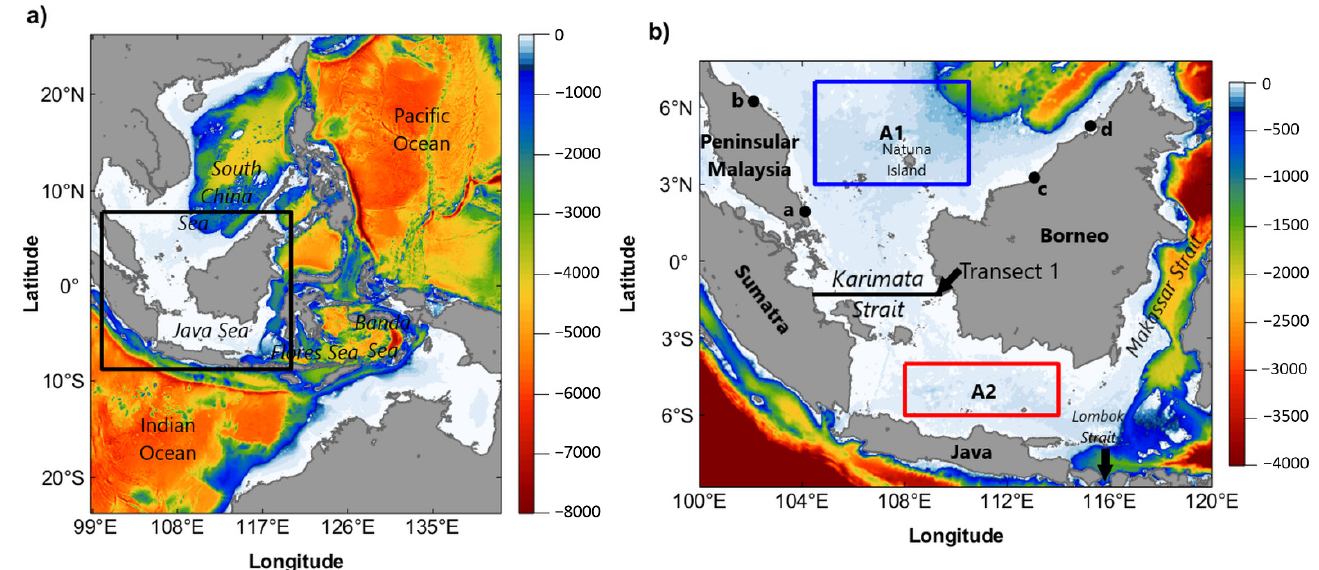
Figure 1. Model domain and bathymetry (unit: m). Black box in ( a ) represent the region of interest as shown in ( b ). Blue and red boxes in ( b ) represent the domains of the SSCS (A1) and the JS (A2). Black line in ( b ) is the transect (Transect 1) used to estimate various Karimata Strait transports (KSTs). Black dots in ( b ) mark the location of four tide gauge stations: (a) Tanjung Selidi, (b) Getting, (c) Bintulu, and (d) Labuan, used to validate the mean sea levels.